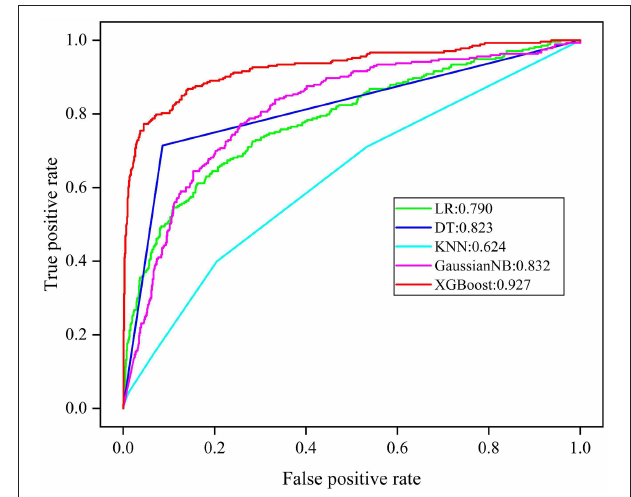
FIGURE 3 | ROC analysis results of five models. LR, logistic regress; DT, decision tree; KNN, K nearest neighbor; GaussianNB, Gaussian naive bayes; XGBoost, extreme gradient